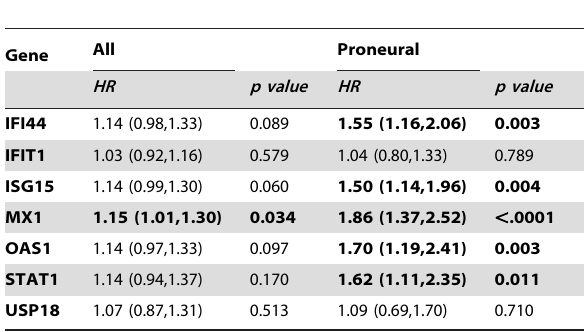
Table 1. Single Gene Cox Proportional Hazards Models with age adjustment for seven genes available in the TCGA discovery (gene-averaged) data set.